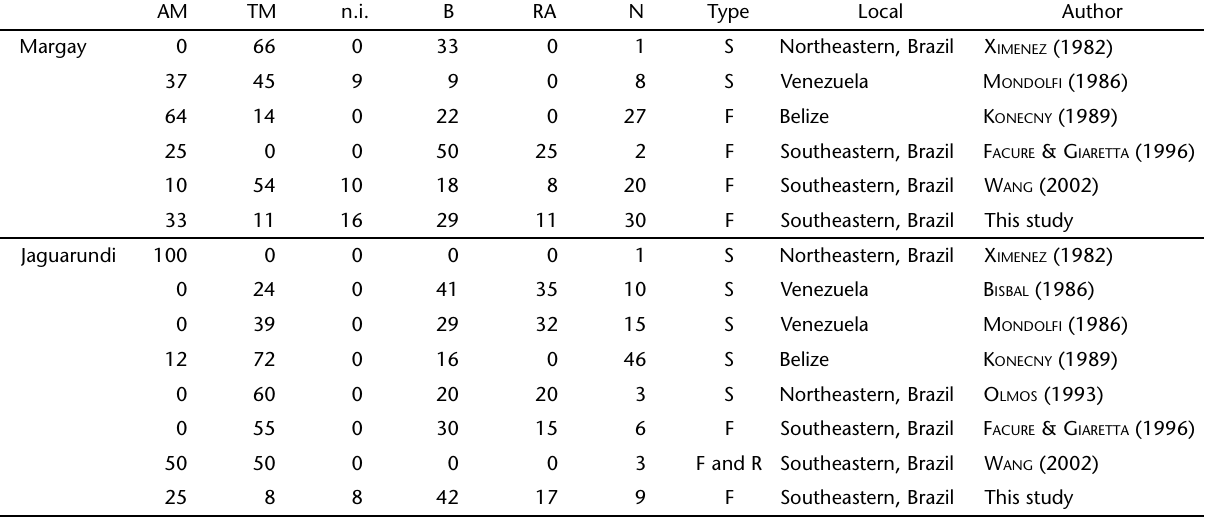
Table II. Main items (percentage of occurrence) reported in diet of the margay and jaguarundi. (AM) Arboreal mammals, (TM) terrestrial mammals, (n.i.) other mammals, (B) birds, (RA) reptiles and amphibians, (n) number of samples, (S) stomach content, (F) sample fecal, (R)